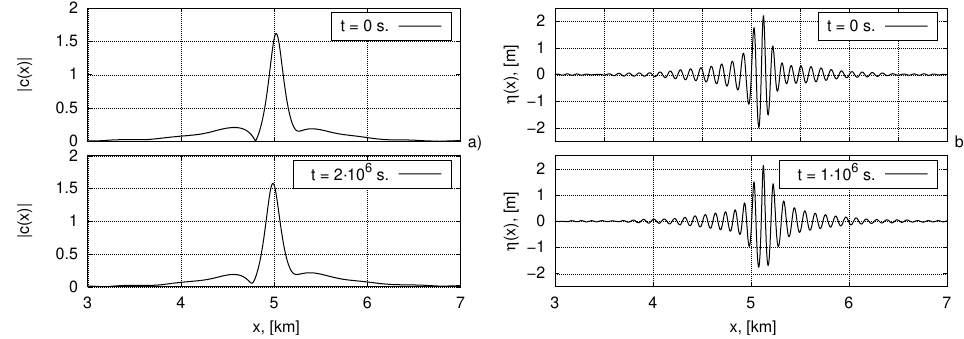
Figure 6. Time evolution of | c ( x ) | in the super compact Dyachenko-Zakharov equation (SCDZE) ( a ) and η ( x ) in RV model ( b ), µ ini = 0.2, µ fin ≈ 0.175, and κ =